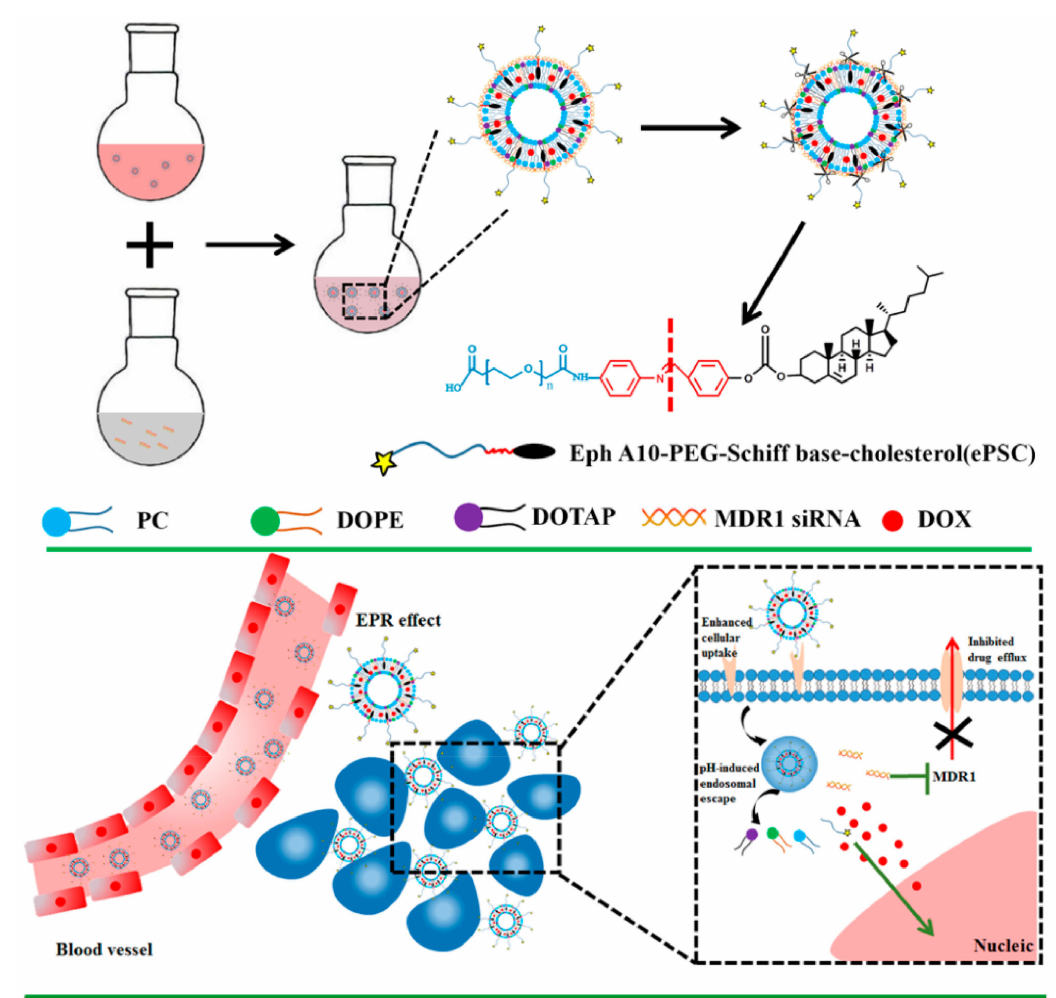
Figure 3. Schematic Illustration of the approach to overcome MDR by multifunctional DOX + siRNA/ePL lipoplexes. Reprinted with permission from Zhang et al. [58]. Copyright (2018) American Chemical